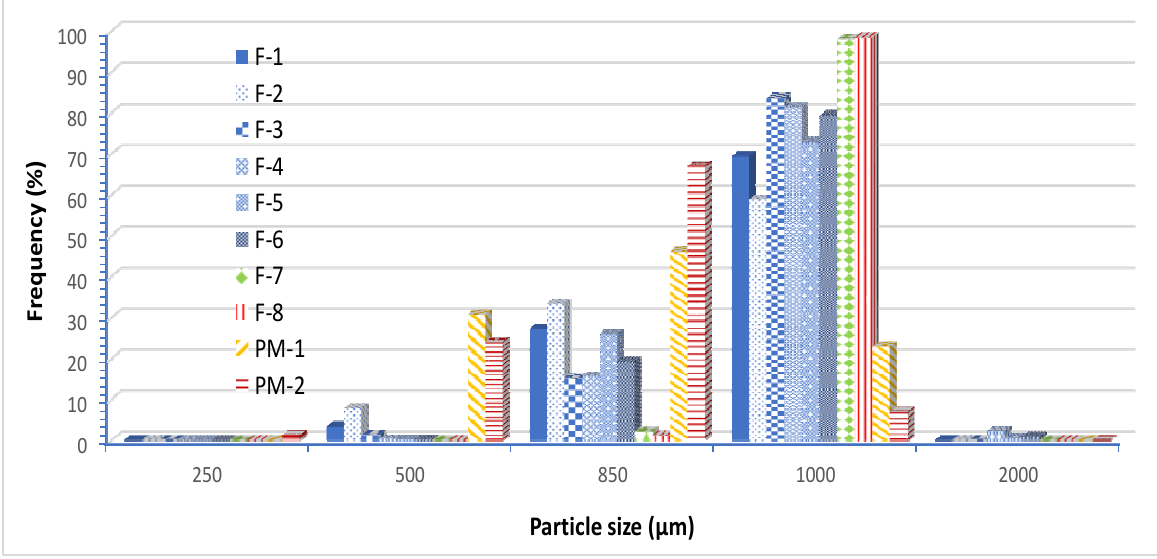
Table 4. Friability and tablet hardness test results of all formulations.